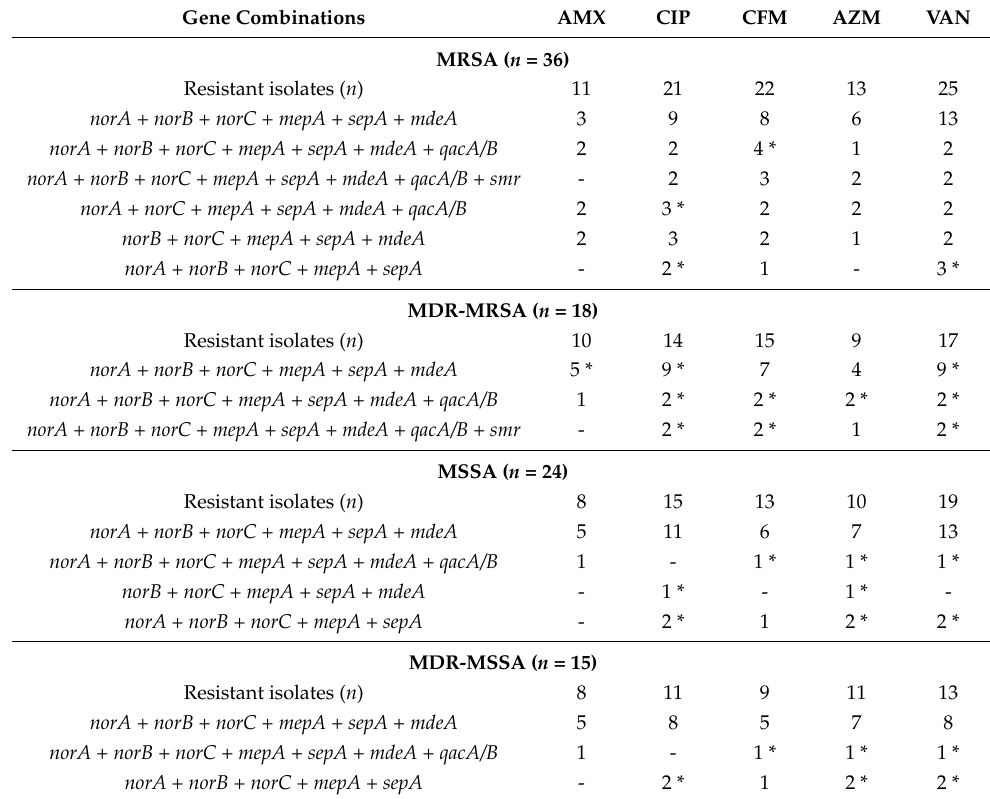
Table 4. Frequency of different combinations of efflux pump genes against different antibiotic resistant clinical